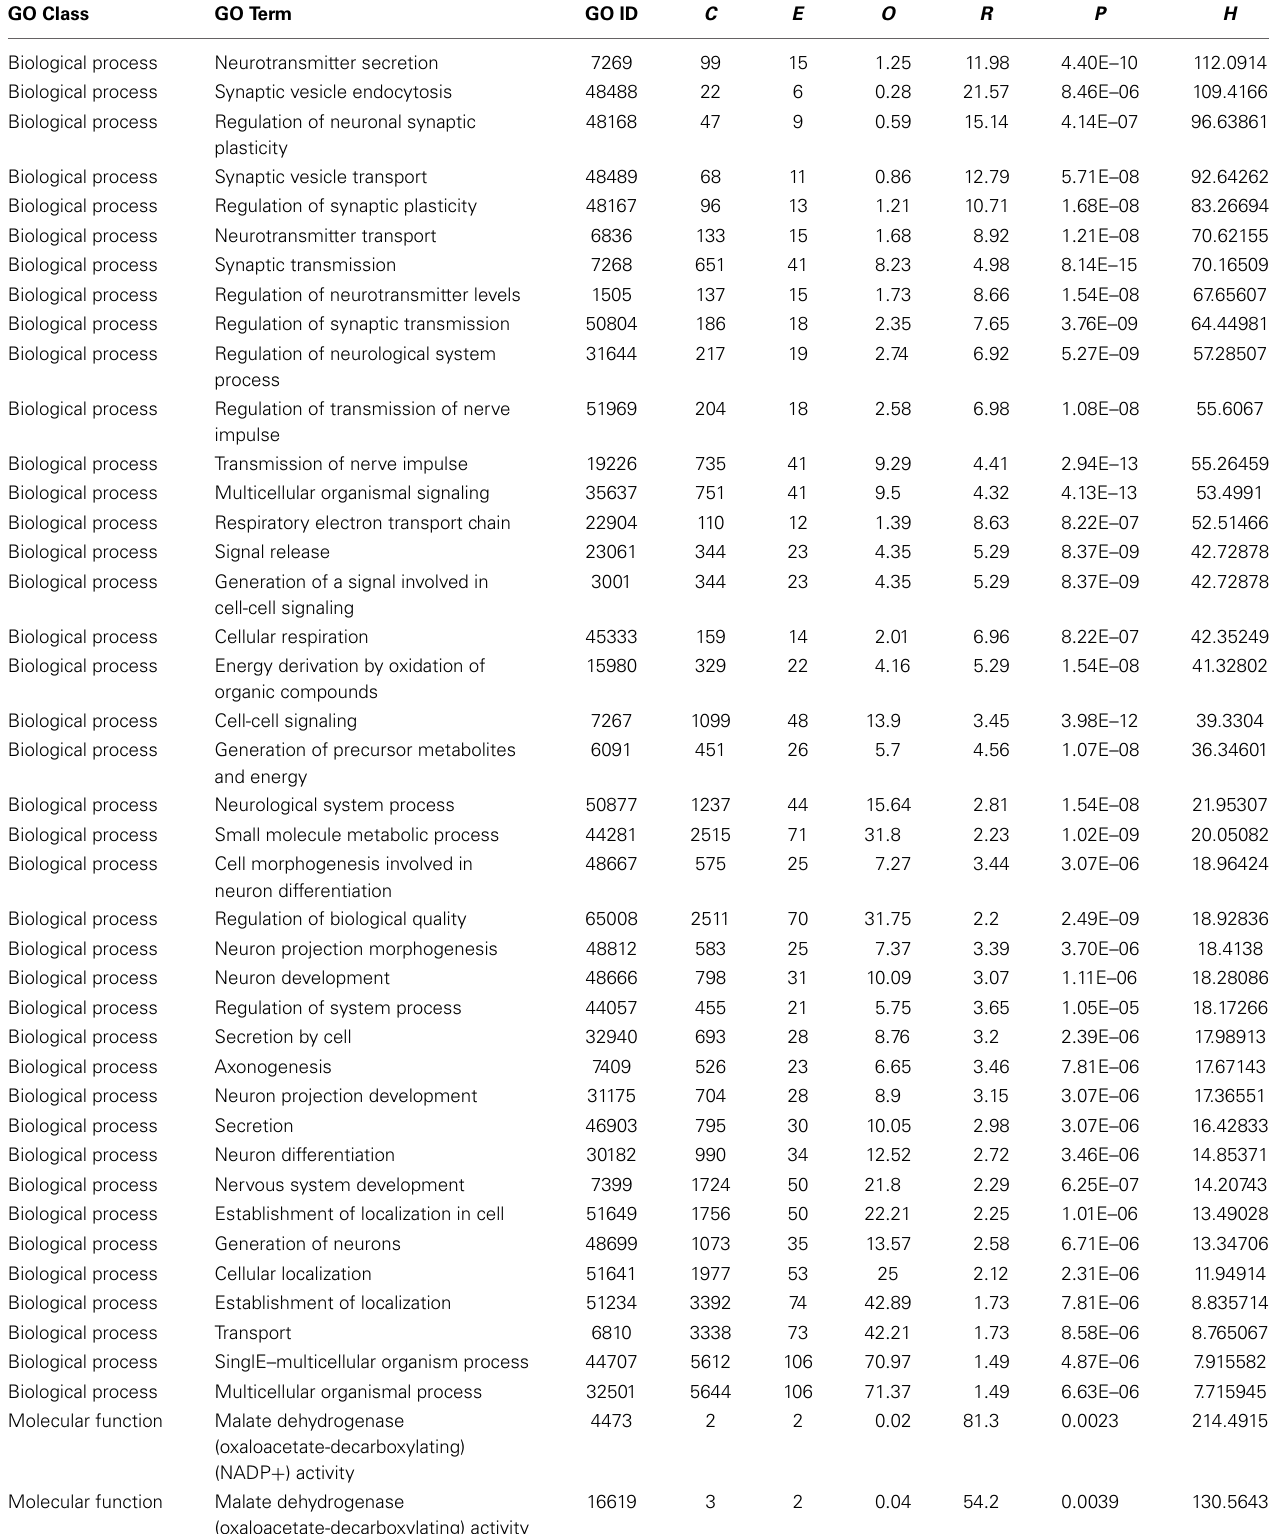
Table 2 | GO term analysis for hippocampal protein alterations observed in aged BTBR compared to WT